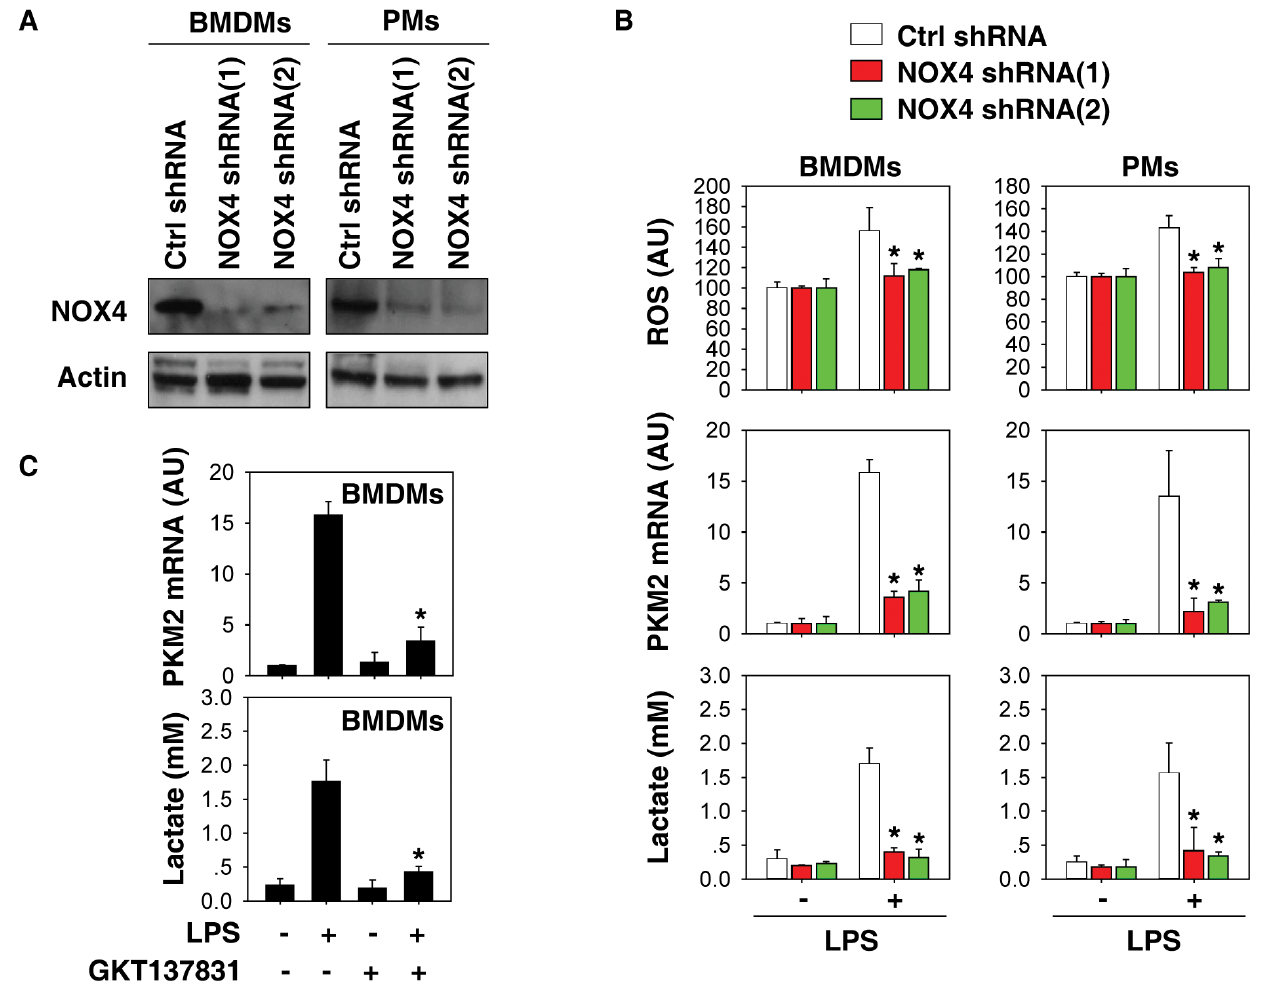
Figure 3. NOX4 is required for PKM2 expression in glycolysis. (A) Western blot analysis of NOX4 expression in control and PKM2 shRNA-treated bone marrow-derived macrophages (BMDMs) and peritoneal macrophages (PMs). (B) Indicated macrophages were treated with lipopolysaccharide (LPS) (100 ng/mL) for 24 h. Relative reactive oxygen species (ROS), PKM2 mRNA, and lactate were assayed (n = 3, *, p < 0.05 versus control shRNA group). (C) Indicated macrophages were treated with LPS (100 ng/mL) in the absence or presence of GKT137831 (1 μ mol/L) for 24 h. PKM2 mRNA and lactate levels were assayed (n = 3, *, p < 0.05 versus LPS